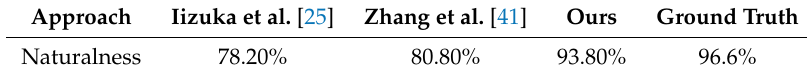
Figure 14. We compare against the other methods. The first column contains the input image; the second column is the result of [25]; the third column is the result of [41]; the fourth column is our result; and the last row is the ground truth. Table 6. Results of our user study evaluating the naturalness of the colorizations.